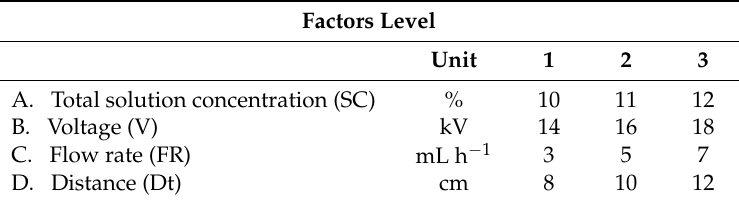
Table 3. Selected factors and their levels used in Taguchi’s design.